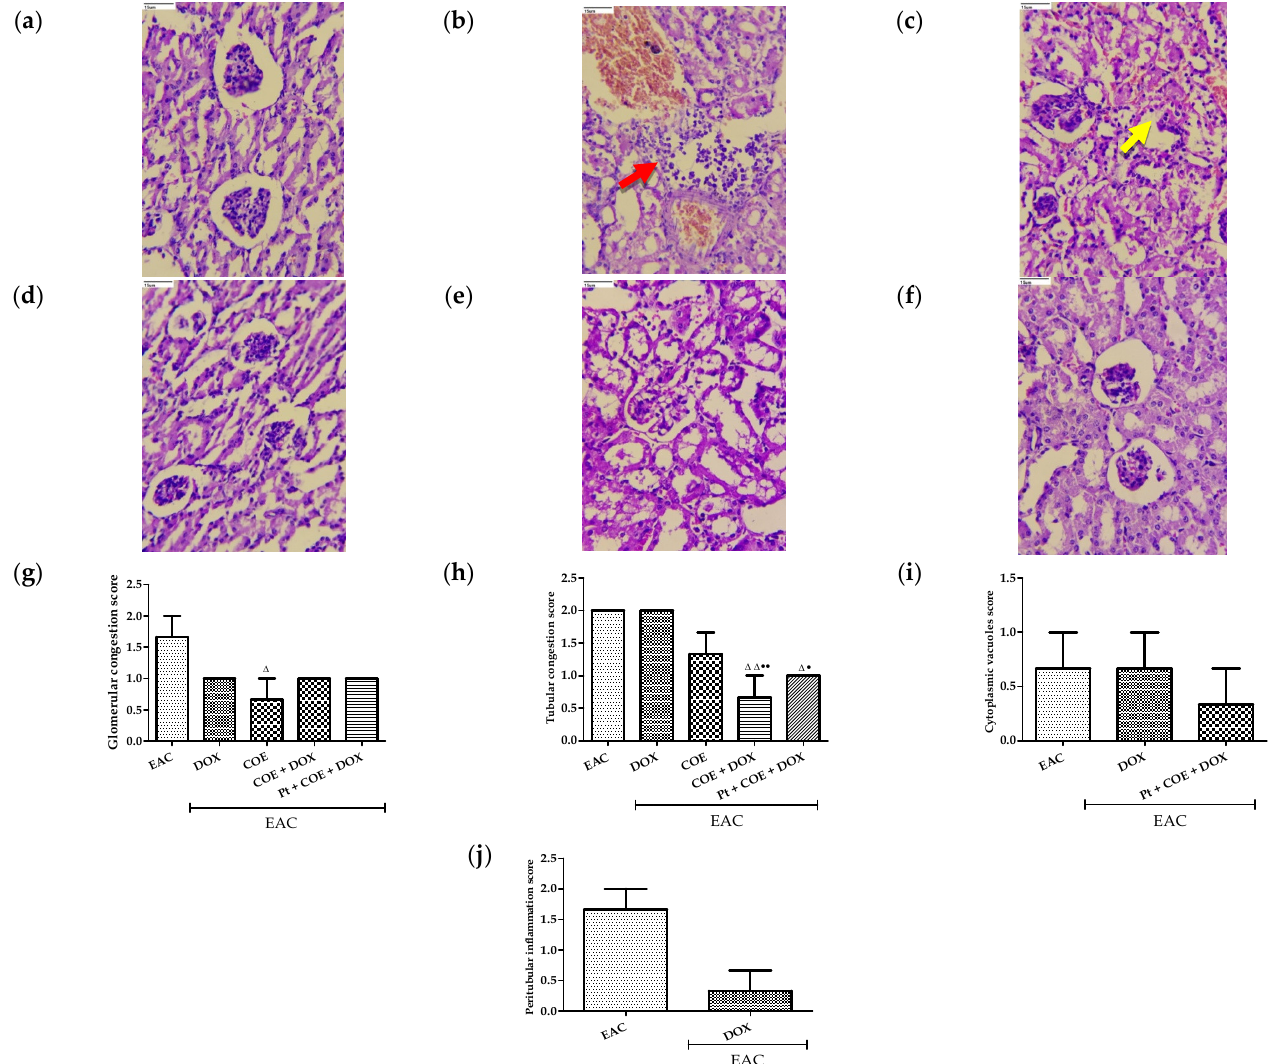
Figure 6. Effect of COE on kidney histology. Photograph of kidney sections of different treatment groups stained with haematoxylin and eosin. Plates at 40× magnification. ( a ) Normal, ( b ) EAC, ( c ) DOX, ( d ) COE, ( e ) COE + DOX, ( f ) Pt +COE + DOX, ( g ) Glomerular congestion score, ( h ) Tubular congestion, ( i ) Cytoplasmic vacuoles score, ( j ) Peritubular inflammation score. EAC group ( b ) showing peritubular inflammation (red arrow) and DOX group ( c ) showing tubular congestion (yellow arrow). All values are expressed as the mean ± SEM (n = 3). Data were analysed using one-way analysis of variance (ANOVA) followed by Tukey’s test. Δ p < 0.05, ΔΔ p < 0.01, compared with EAC; ● p < 0.05, ●● p < 0.01, compared with DOX.